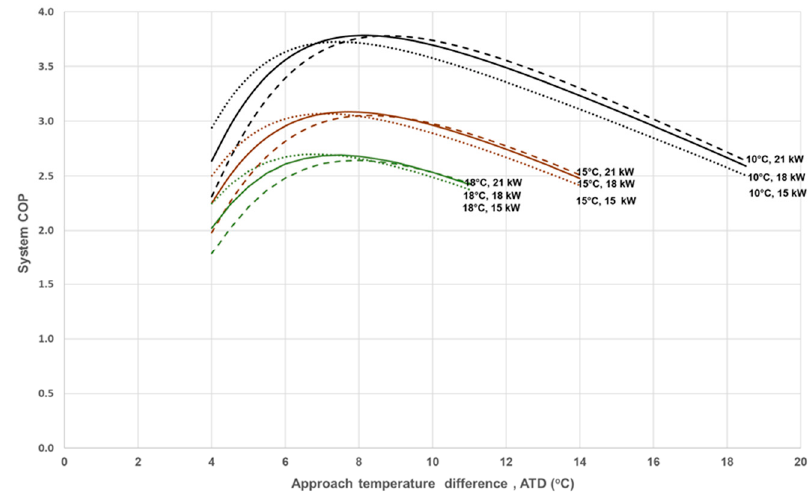
Figure 12. The system coefficient of performance (COP) vs. condenser ATD at various T C-IN (10 ◦ C, 15 ◦ C, 18 ◦ C), evaporator loads (15, 18, 21 kW) and at a constant suction pressure of 30.5 bar when the DPC is operating.